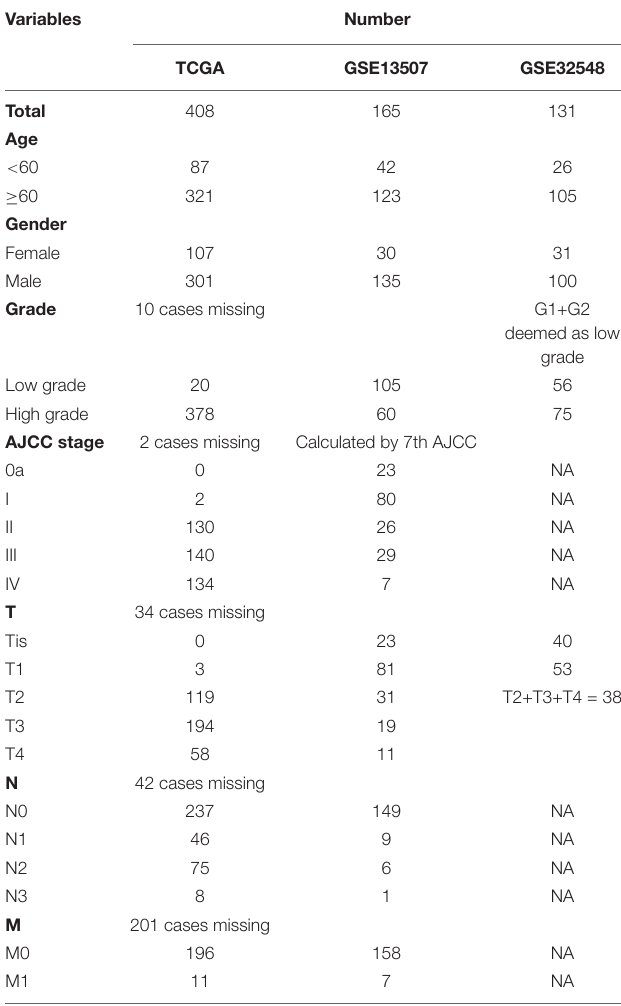
TABLE 1 | Baseline clinical characteristics of three databases.